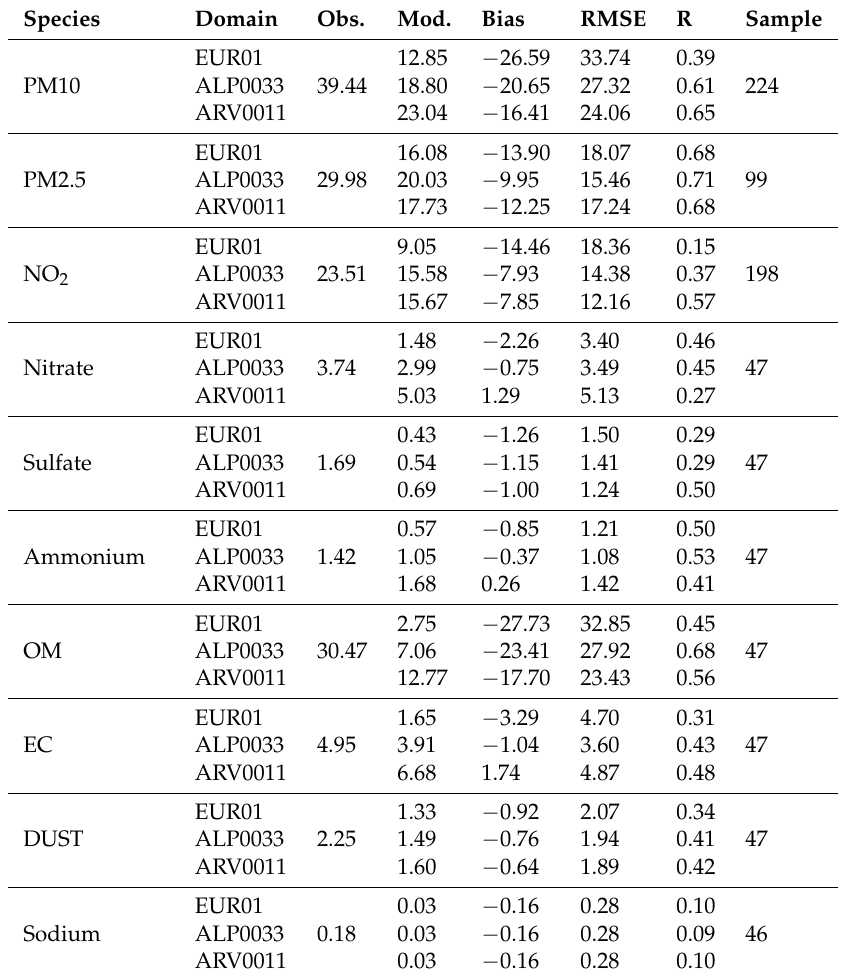
Table 7. Error statistics for the main pollutants. Mod., Obs., Bias and RMSE are respectively the mean model data, mean observations, mean bias and the root mean square error in µ g m − 3 for the 15 November to 20 December period. R is the Pearson product-moment spatio-temporal correlation coefficient (unit less). Calculations are done for the stations in the ARV0011 domain